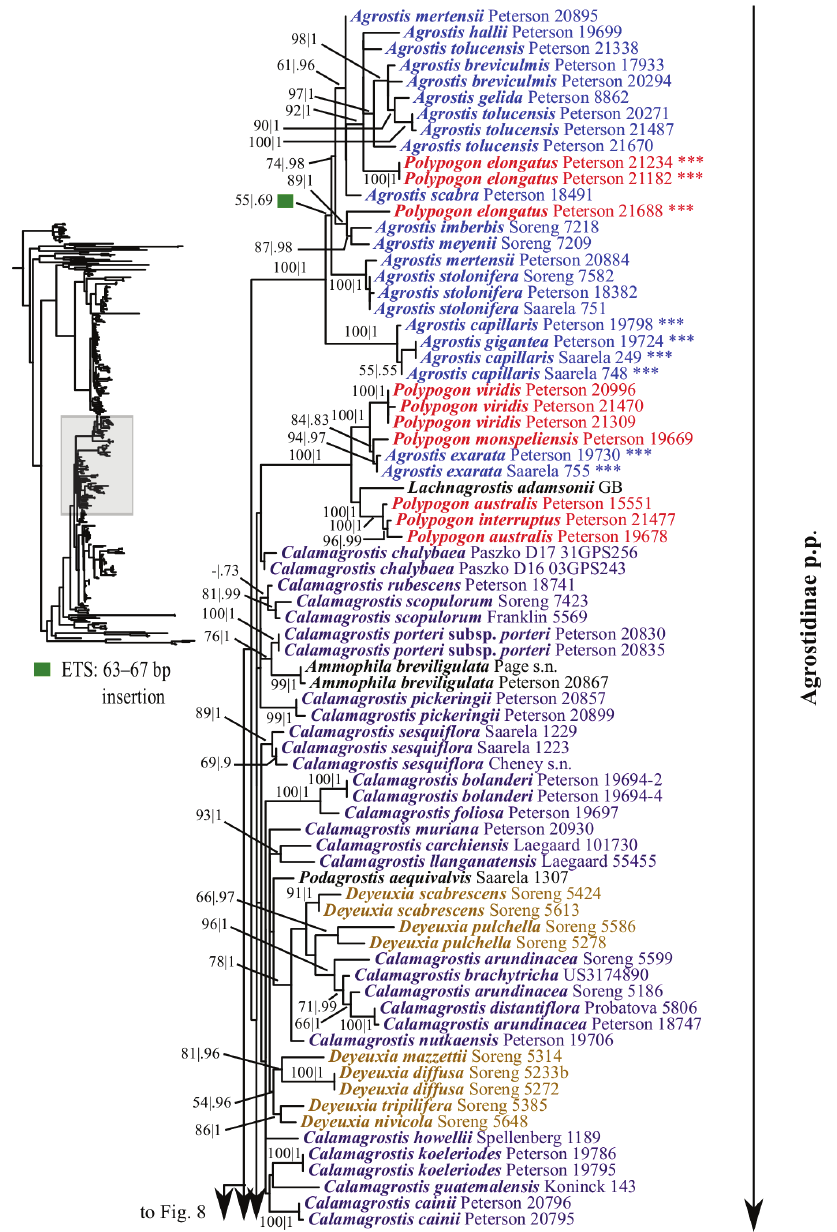
Figure 7. A portion (part of Agrostidinae p.p.) of the maximum likelihood phylogram inferred from ITS+ETS data. ML bootstrap support (left) and BI poster probabilities (right) are recorded along branch- es. A dash indicates bootstrap support <50%. No support is shown for branches with bootstrap support <50% and posterior probability <.5. The shaded area of the smaller tree on the left indicates the location in the overall tree of the portion shown. Placements of samples with asterisks (***) are incongruent in nrDNA and plastid trees. One indel in ETS is mapped onto the